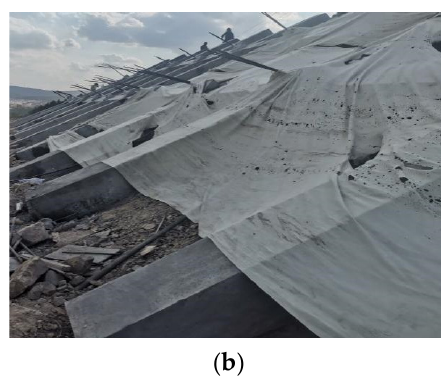
Figure 12. Slope treatment scheme.